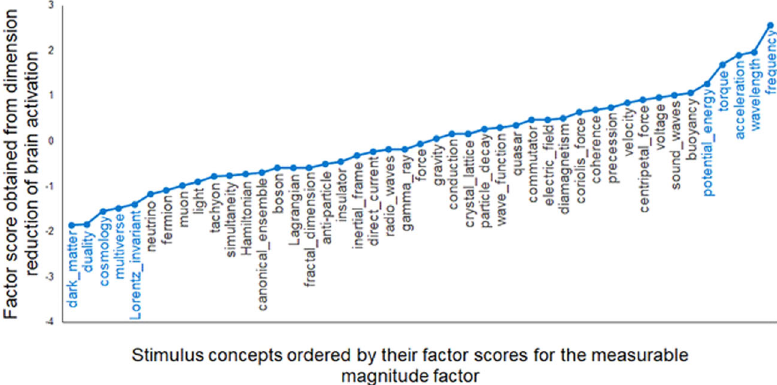
Fig. 1 The fMRI-based factor scores for the 45 concepts on the measureable magnitude dimension (vertical axis). The contrast between the concepts at the two ends of the dimension (highlighted in blue text) indicates the nature of the dimension.